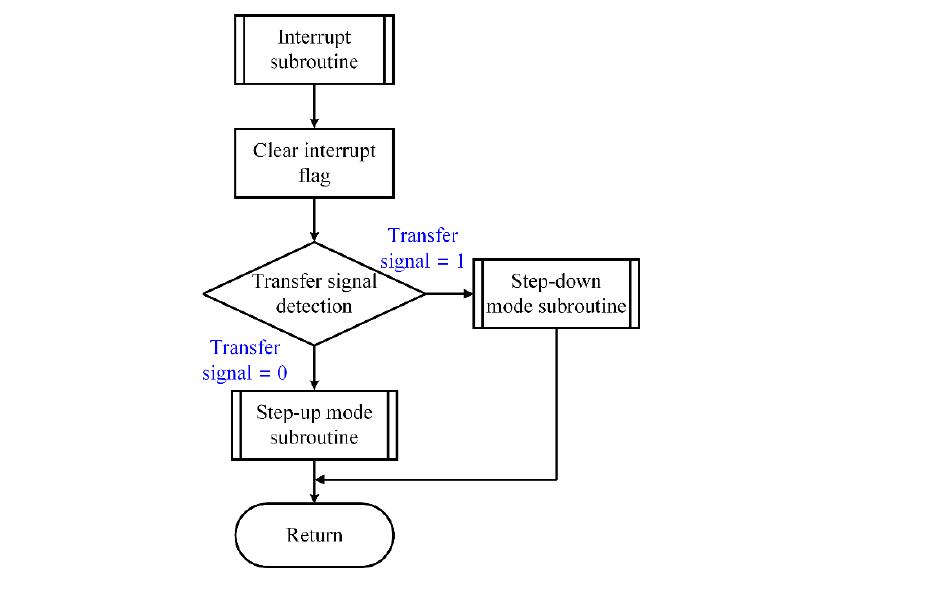
Figure 12. Flow chart of the interrupt subroutine.